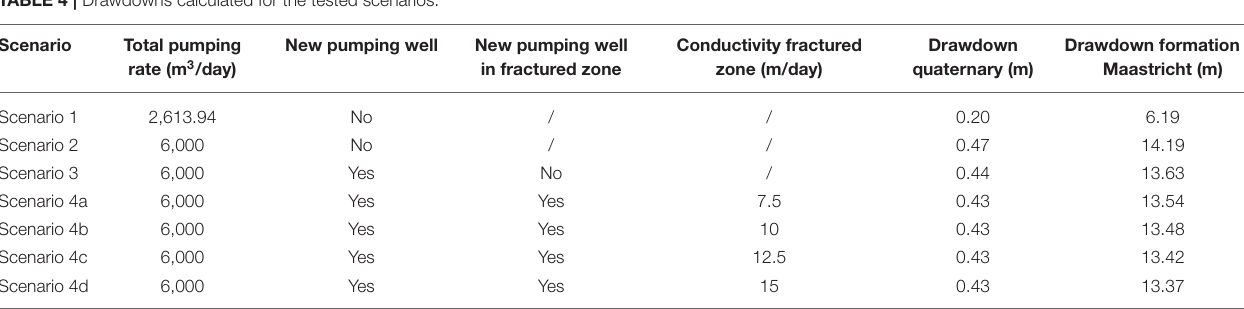
TABLE 4 | Drawdowns calculated for the tested